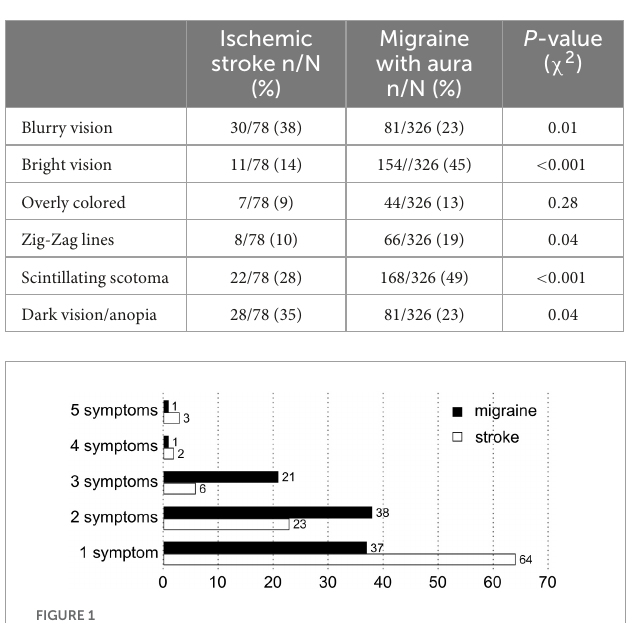
TABLE 1 Visual symptoms in patients with ischemic stroke and migraine aura.